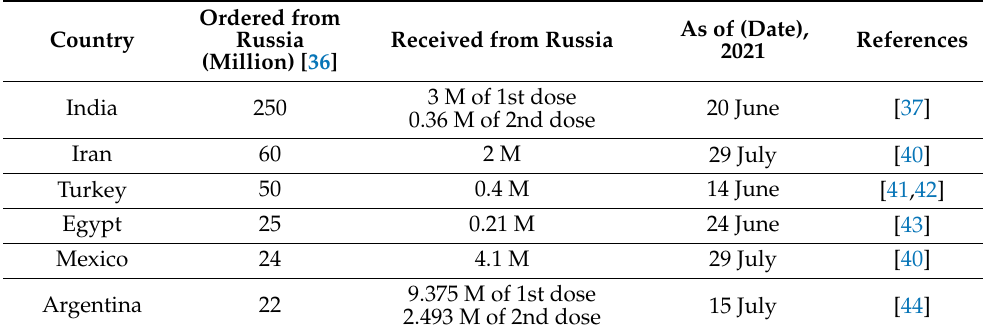
Table 2. Number of doses of Sputnik V ordered and received from Russia as of 31 July 2021.